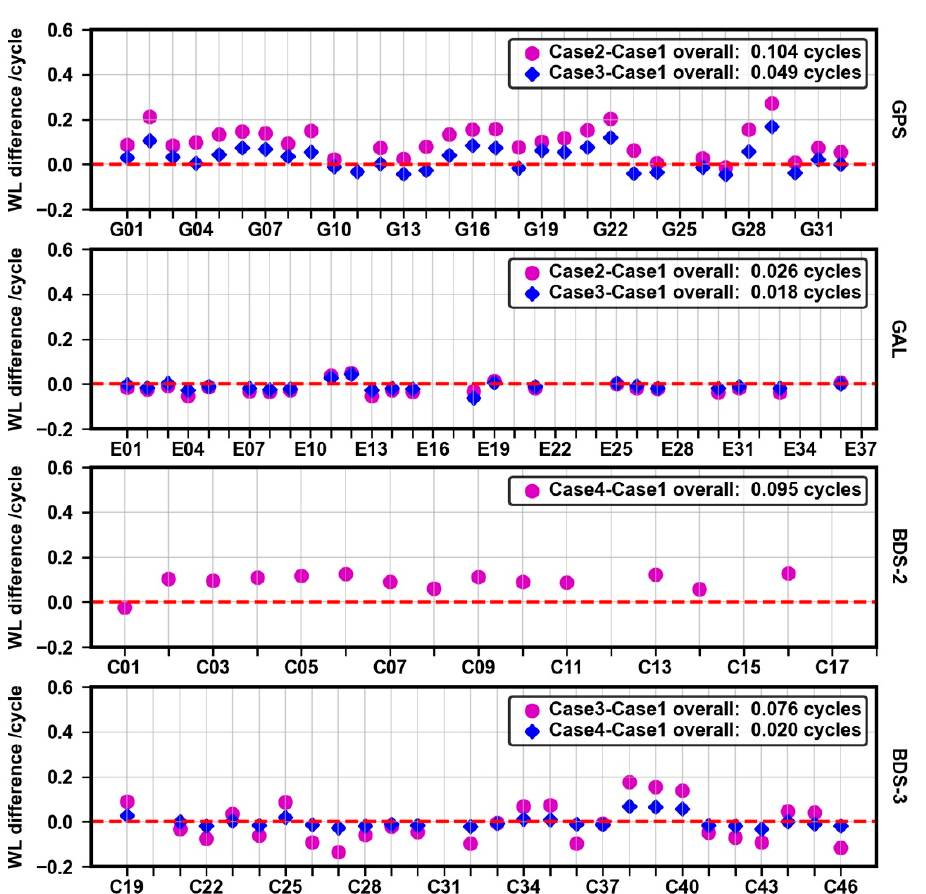
Figure 6. WL phase bias differences of different network strategies relative to Case 1 without the calibration.